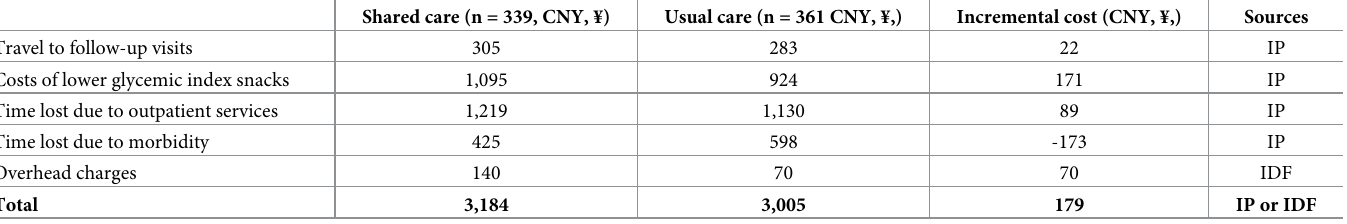
Table 2. Direct non-medical and indirect costs associated with a lifestyle intervention program for women with gestational diabetes in China, per study participant, by study arm. Shared care (n = 339, CNY, ¥) Usual care (n = 361 CNY, ¥,) Incremental cost (CNY,